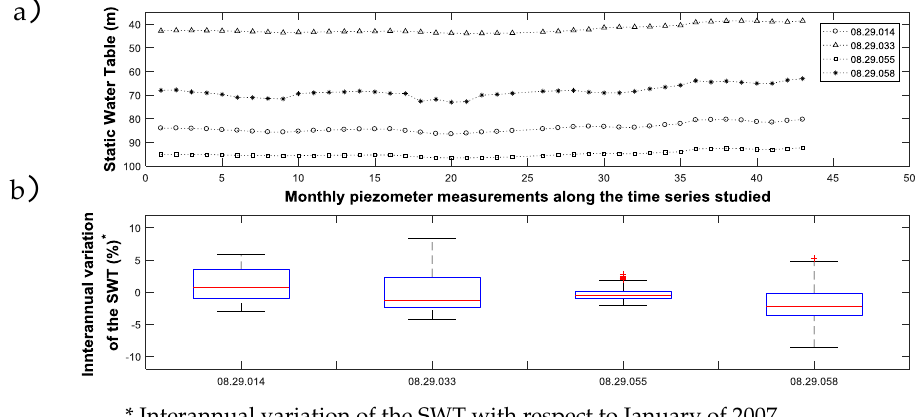
Figure 5. Static water table ( a ) and monthly interannual variation ( b ) for each piezometer in WUA B.